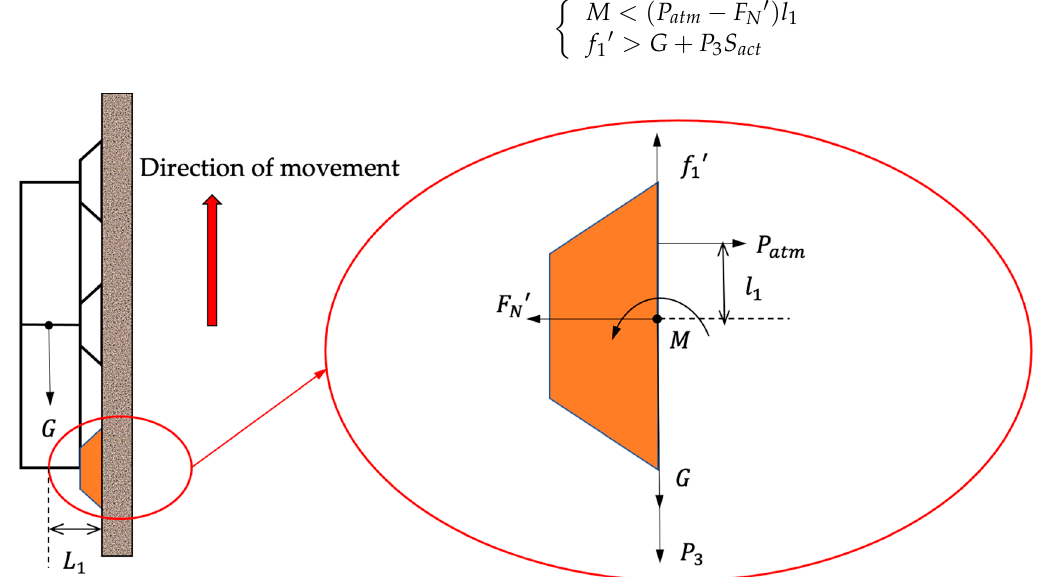
Figure 12. Force analysis of the lower-end sucker during the gait (2) of the robot when wall crawling.